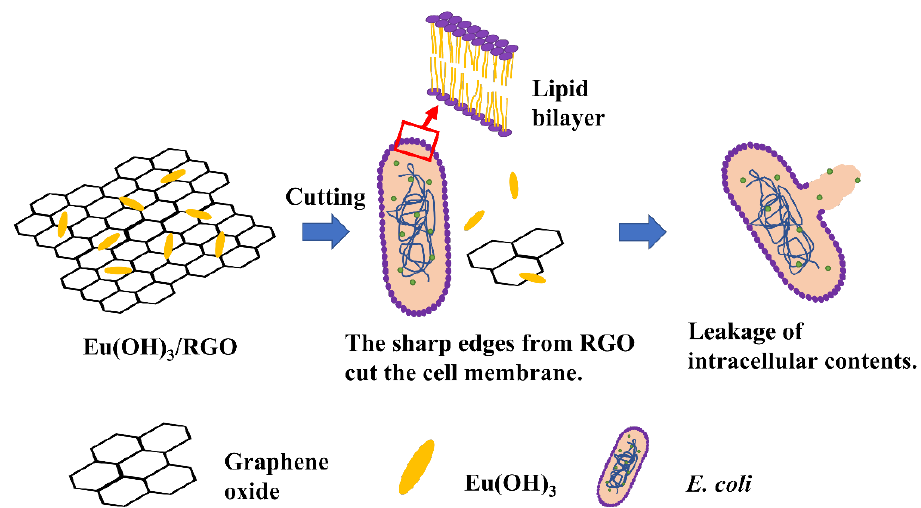
Figure 10. Plausible antibacterial mechanism of Eu(OH) 3 /RGO nanocomposites.